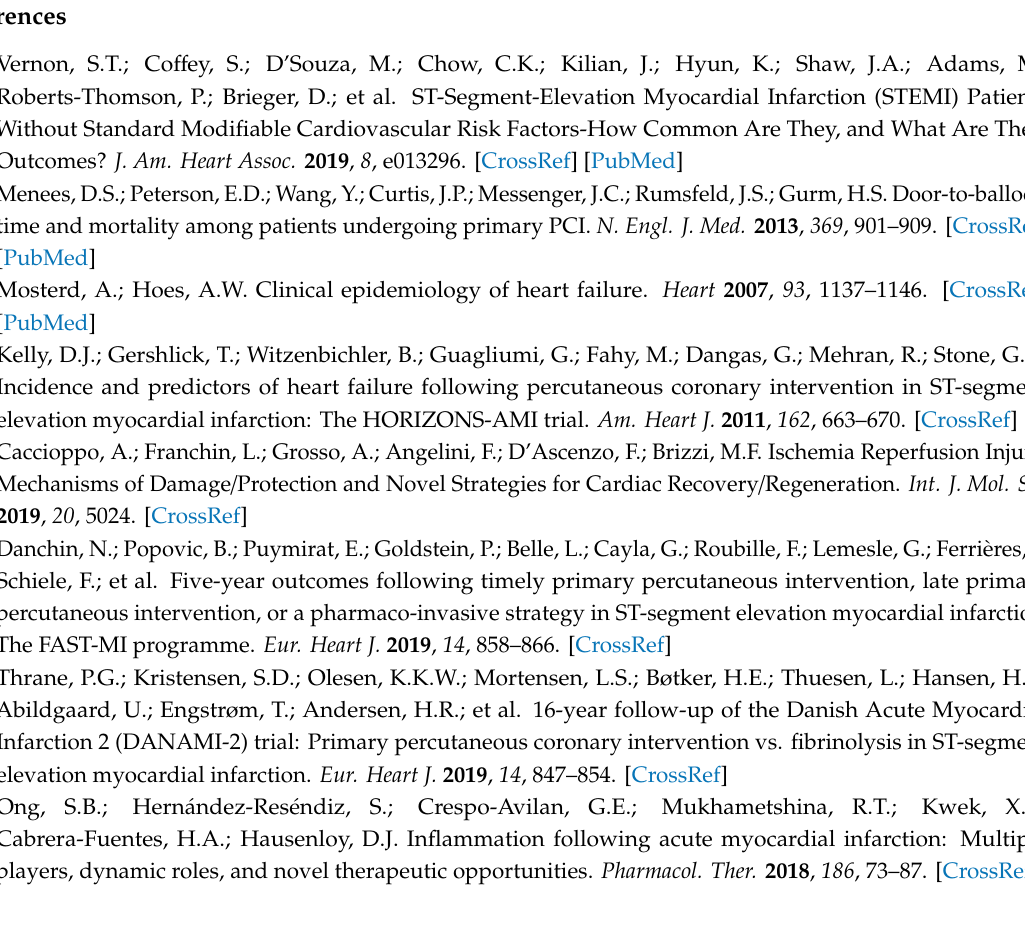
Figure S1: STROBE diagram of the subjects and the study design; Figure S2: miR-320a expression in serum and PBMCs of STEMI patients compared to healthy controls; Figure S3: miR-320a expression in PBMCs of STEMI patients compared to healthy controls; Figure S4: Receiver-operating characteristic (ROC) curves comparing sensitivity and specificity of Creatine Kinase and Age in predicting left ventricular adverse remodelling